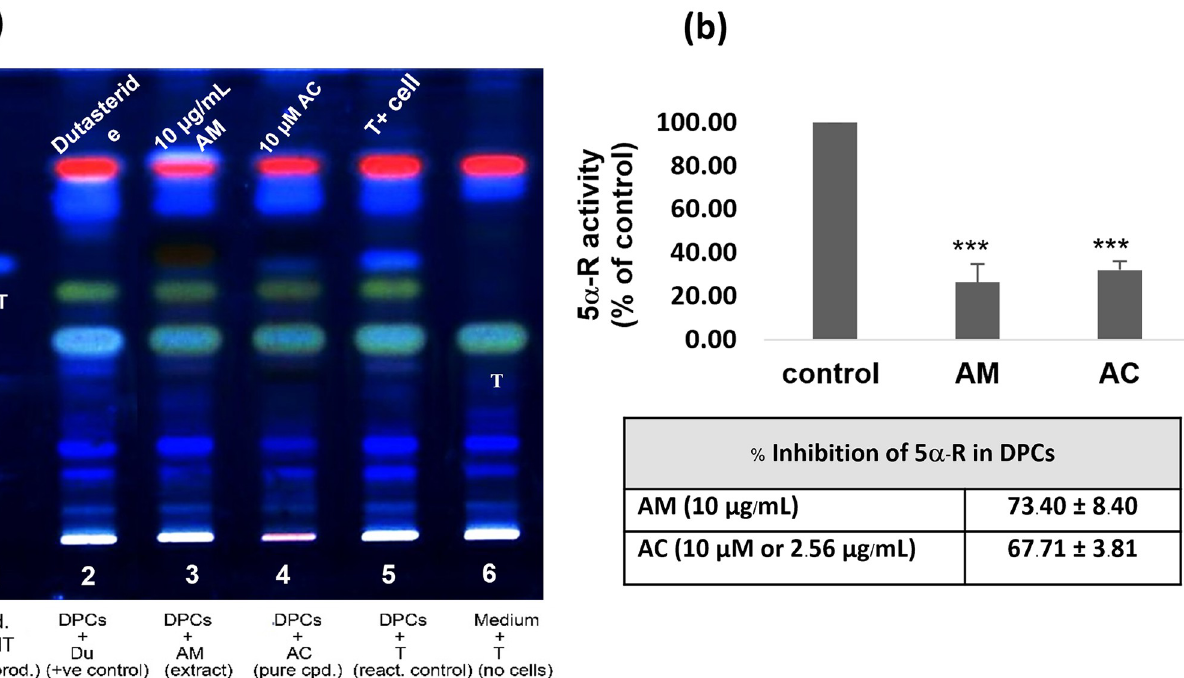
PLOS ONE | https://doi.org/10.1371/journal.pone.0284853 April 21,